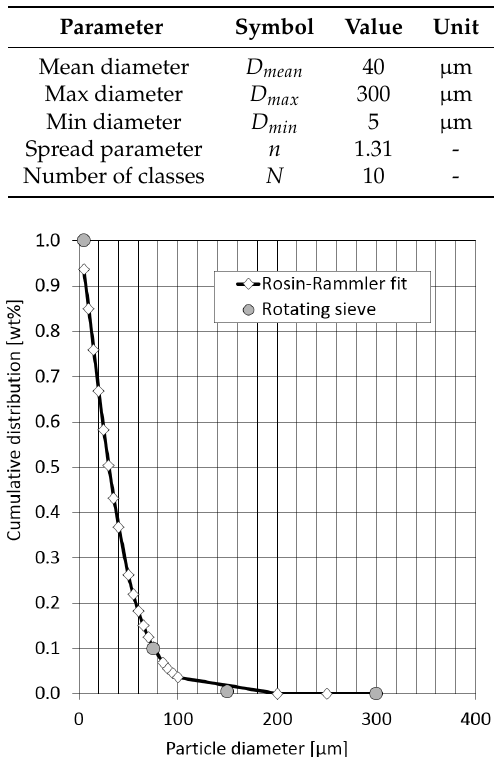
Figure 6. Kleinkopje’s coal particle